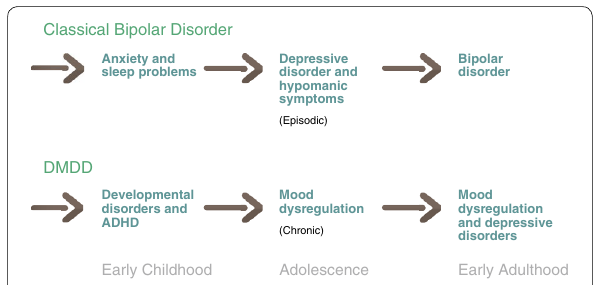
Fig. 1 Developmental trajectory of bipolar disorder vs severe mood dysregulation or disruptive mood disregulation